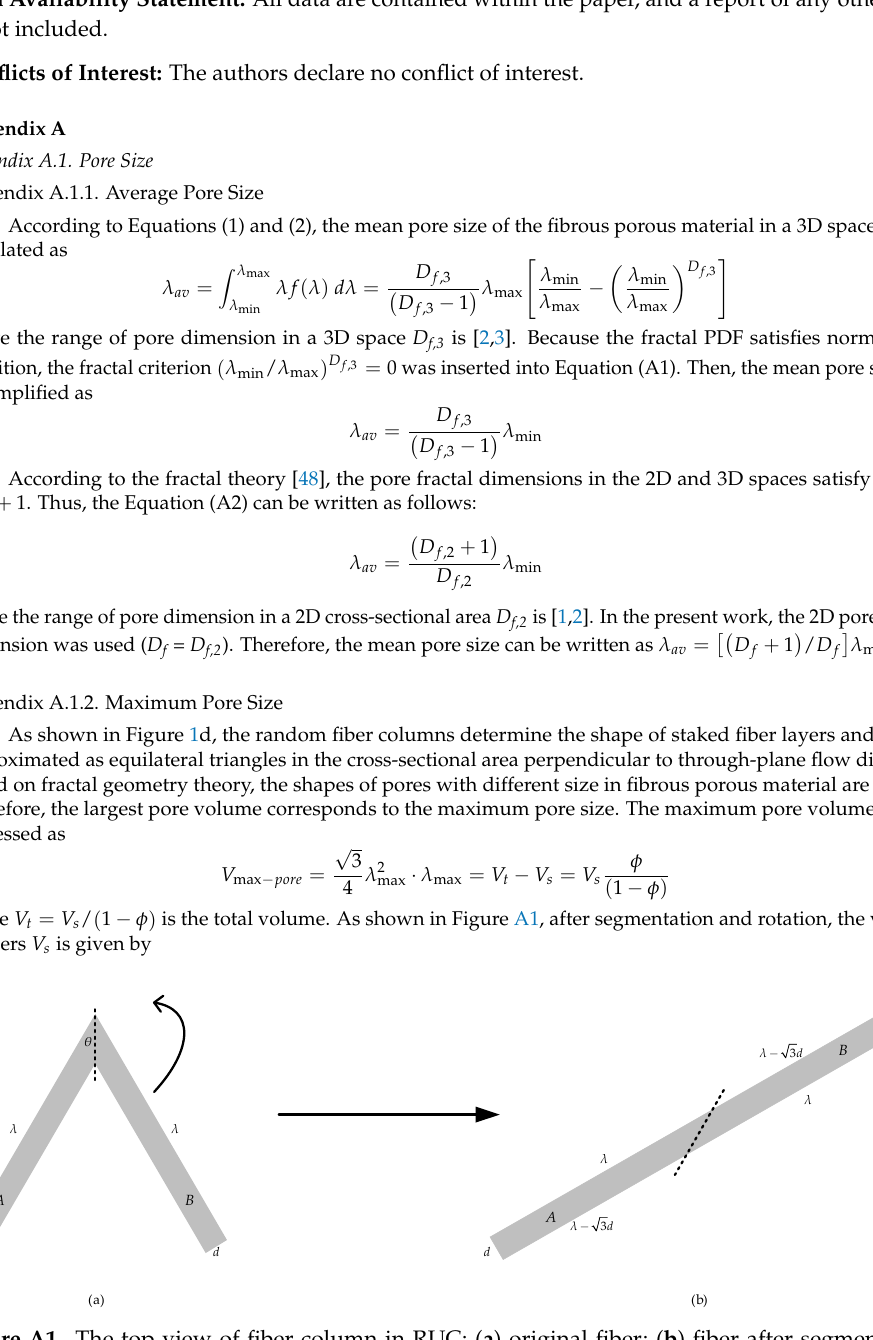
Figure A1. The top view of fiber column in RUC: ( a ) original fiber; ( b ) fiber after